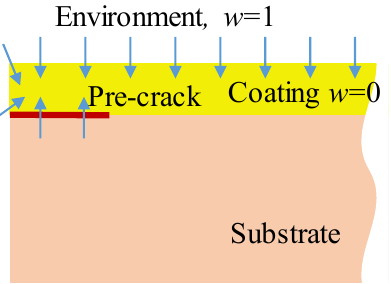
Figure 3. Schematic of boundary conditions for moisture absorption.